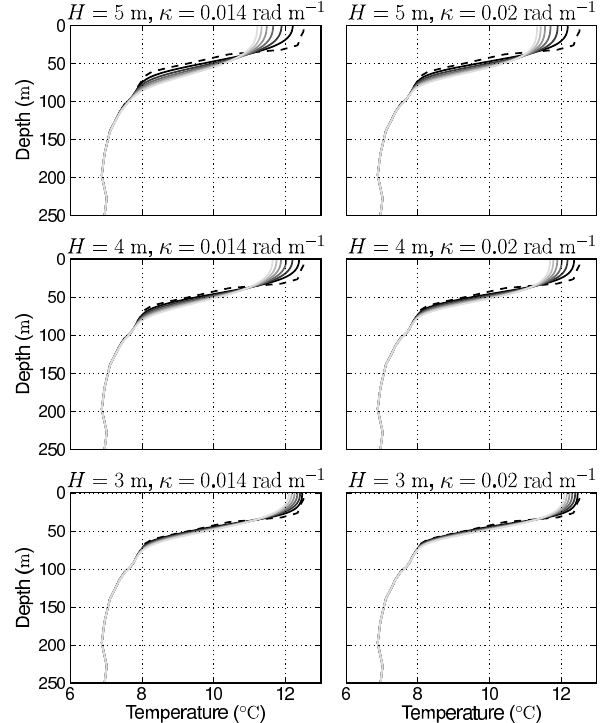
Fig. 3. Mixing in GOTM due to non-breaking wave-induced turbu- lence using the B v parameterisation for monochromatic waves with α =1 from Qiao et al. (2010). The range of wave heights and wave numbers is as for Fig.